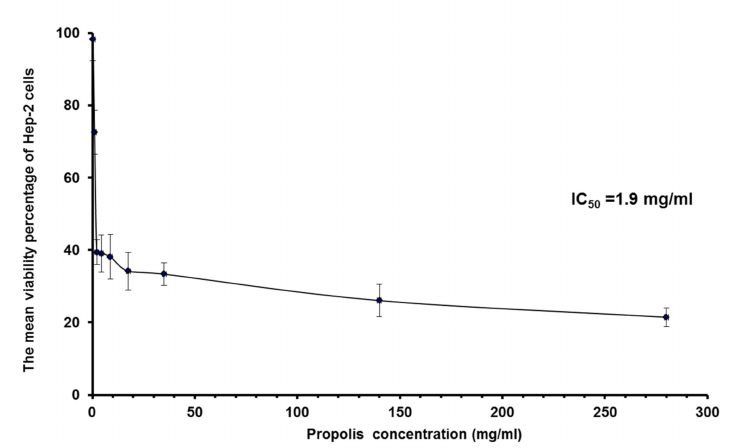
Figure 3. The mean viability percentage of HEP-2 cells treated with different concentrations of propolis extract.